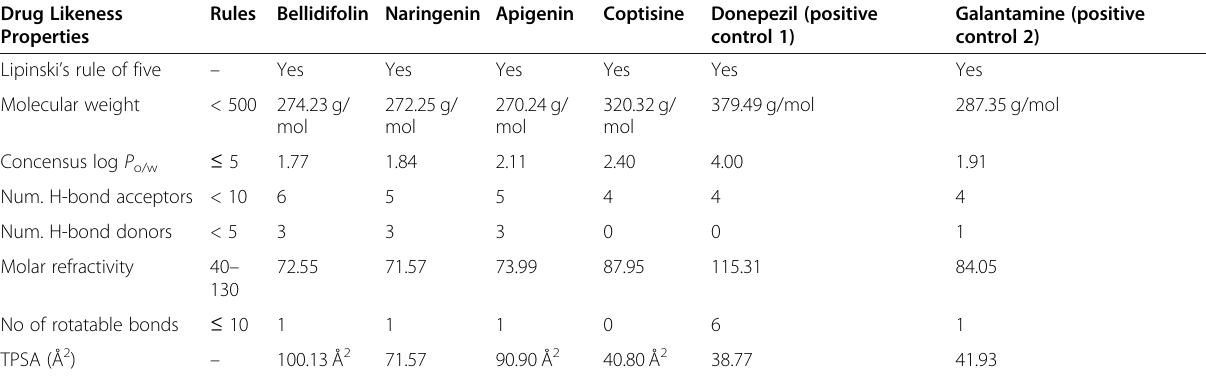
Table 5 The druglikeness properties of the best 4 ligands and the positive controls Drug Likeness Properties Lipinski ’ s rule of five